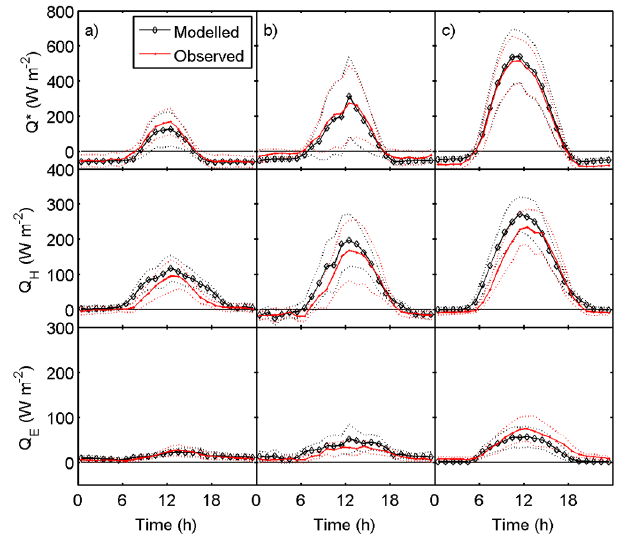
Figure 11. As Fig. 10, for the urban site in Montreal (Rl) in 2008– 2009.